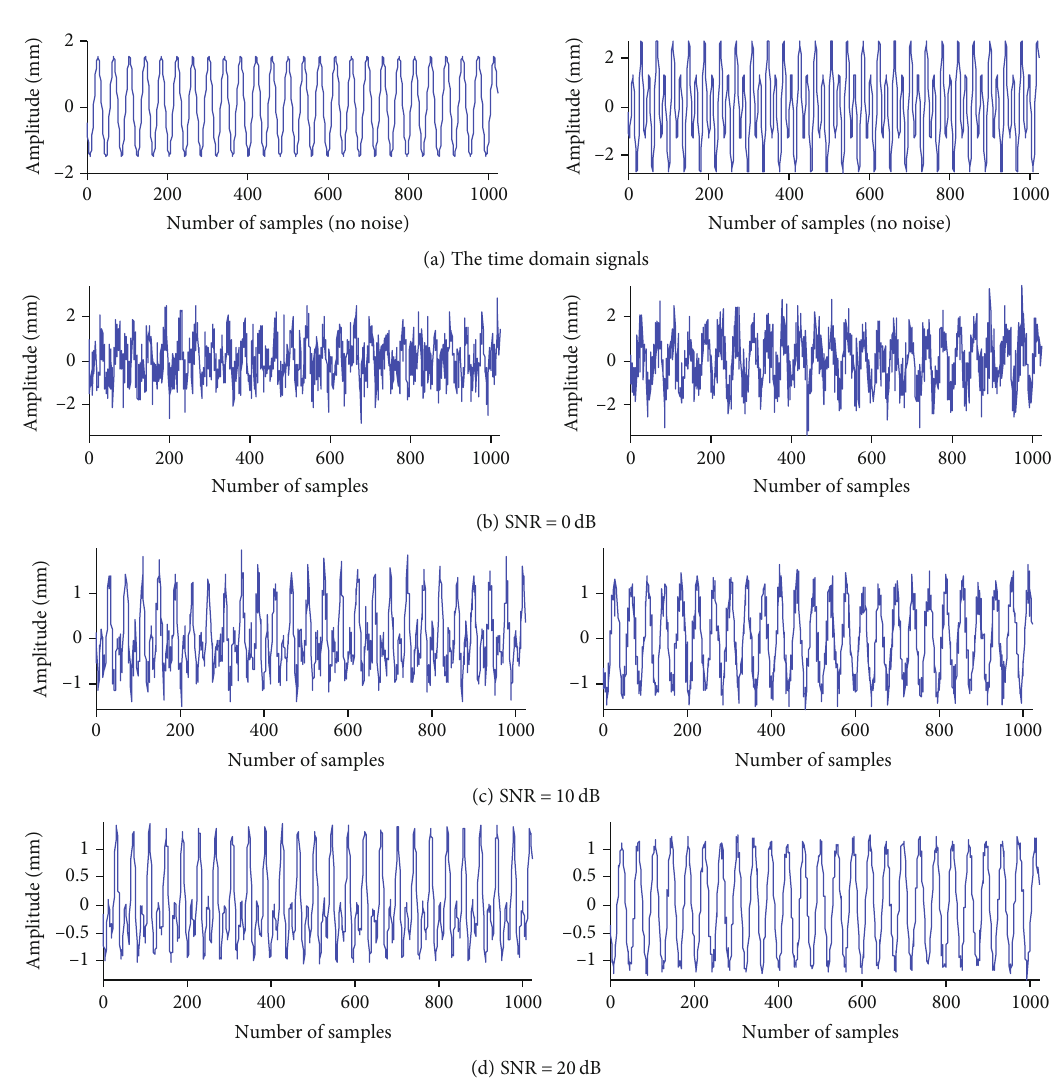
Figure 3: Noisy signals with di ff erent input SNRs.